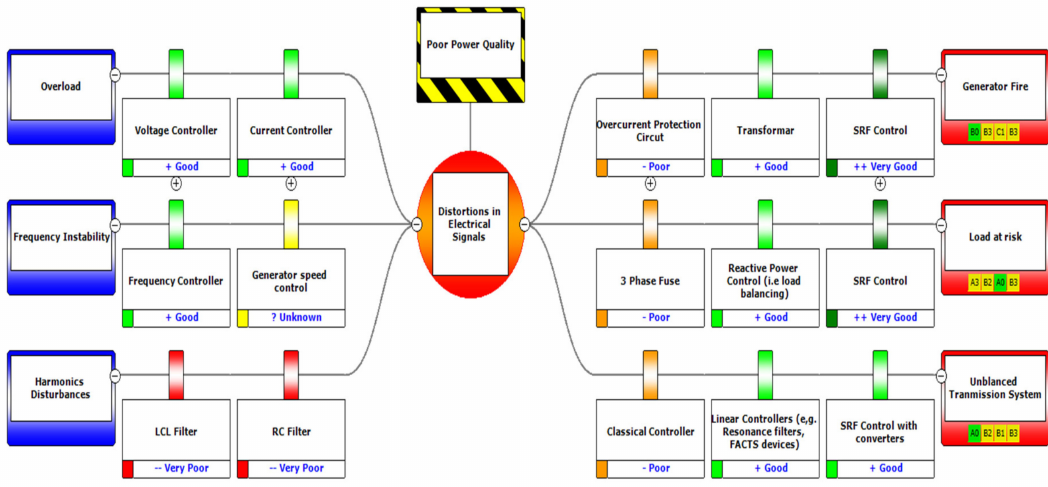
Figure 1. Bowtie analysis of distortions in electrical